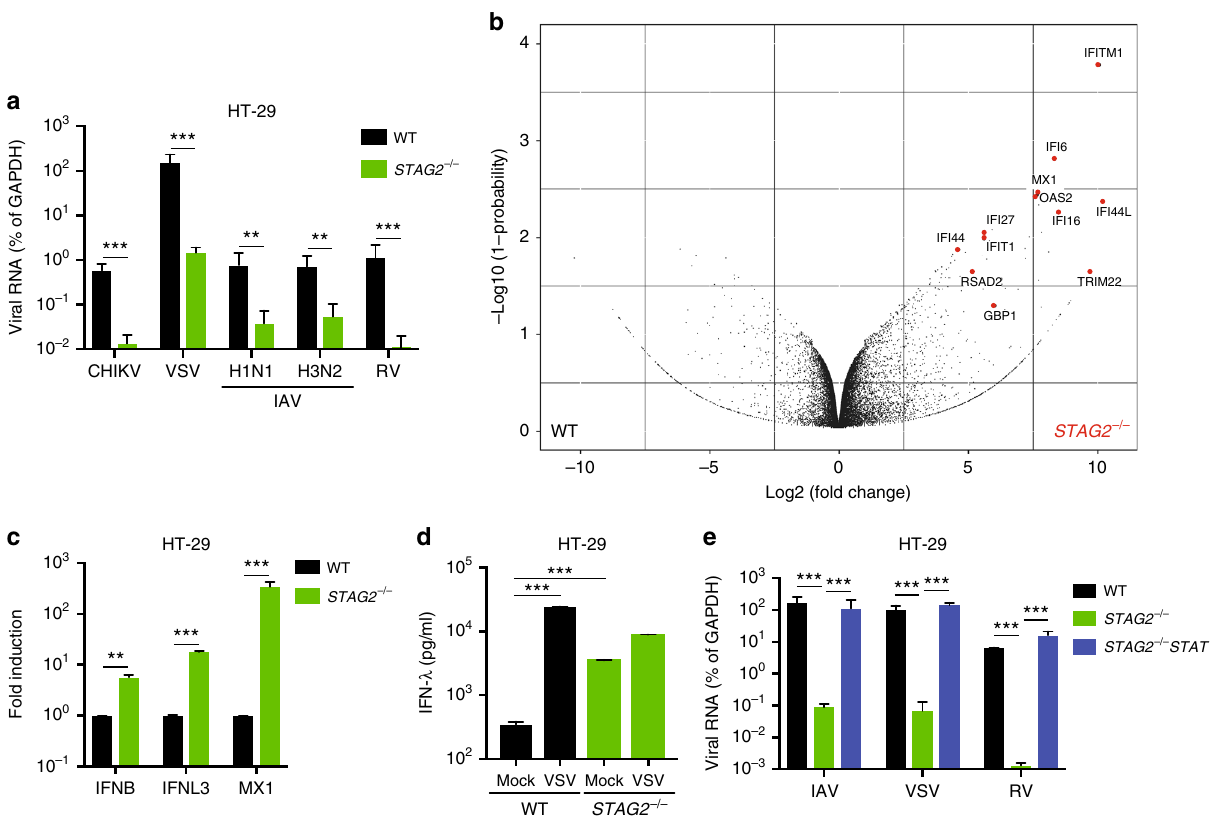
Fig. 2 Loss of STAG2 triggers excessive IFN production. a WT and STAG2 − / − HT-29 cells were infected with the indicated viruses (MOI = 1) and respective viral genes were measured by RT-qPCR at 24 h.p.i. CHIKV chikungunya virus, VSV vesicular stomatitis virus, IAV in fl uenza A virus. b Volcano plot of RNA-sequencing data (BGI system) from uninfected WT and STAG2 − / − HT-29 cells. c IFN and ISG expression was examined by RT-qPCR. d IFN- λ secretion was measured by ELISA. e WT, STAG2 − / − , and STAG2 − / − STAT1 − / − HT-29 cells were infected with IAV, VSV, and RV (MOI = 1) and viral mRNA level was measured at 24 h.p.i. by RT-qPCR. For all fi gures except b , experiments were repeated at least three times in triplicates. Experiment of b was performed in duplicates on two different sequencing platforms. Data are represented as mean ± SEM (**p ≤ 0.01; ***p ≤